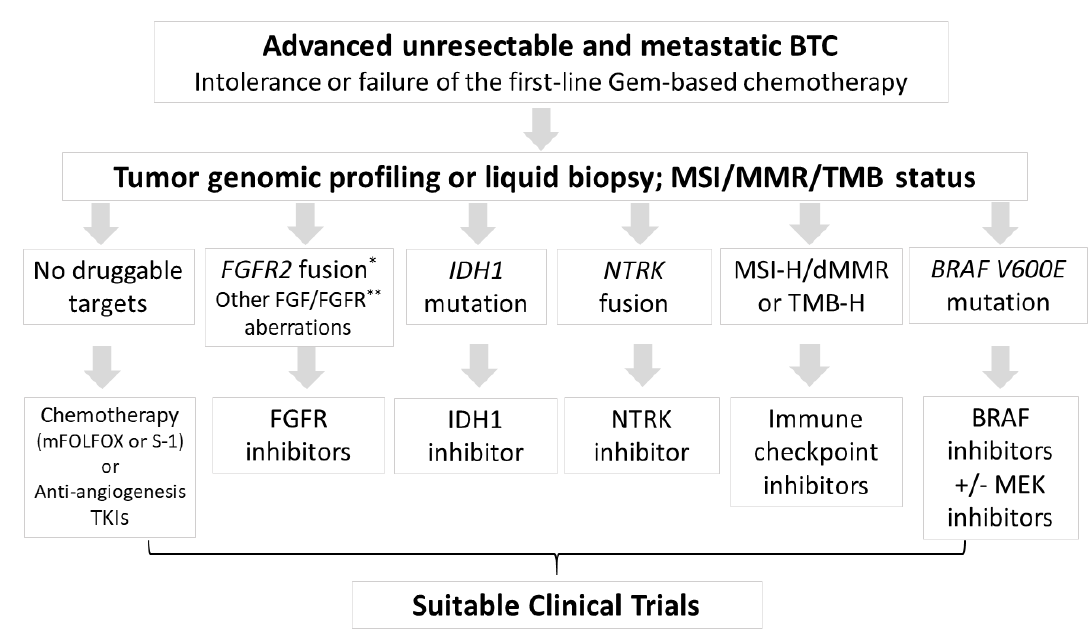
Figure 1. Flow chart for therapeutic choices after intolerance or failure to gemcitabine-based chemotherapy. According to the genetic alternations from tumor genomic profiling or liquid biopsy, some specific inhibitors were suggested in specific populations. MSI-H, microsatellite instability high; dMMR, deficiency of mismatch repair; TMB-H, tumor mutation burden high; TKI, tyrosine kinase inhibitors. * FGFR2 fusion or rearrangement; ** such as mutation or amplification.